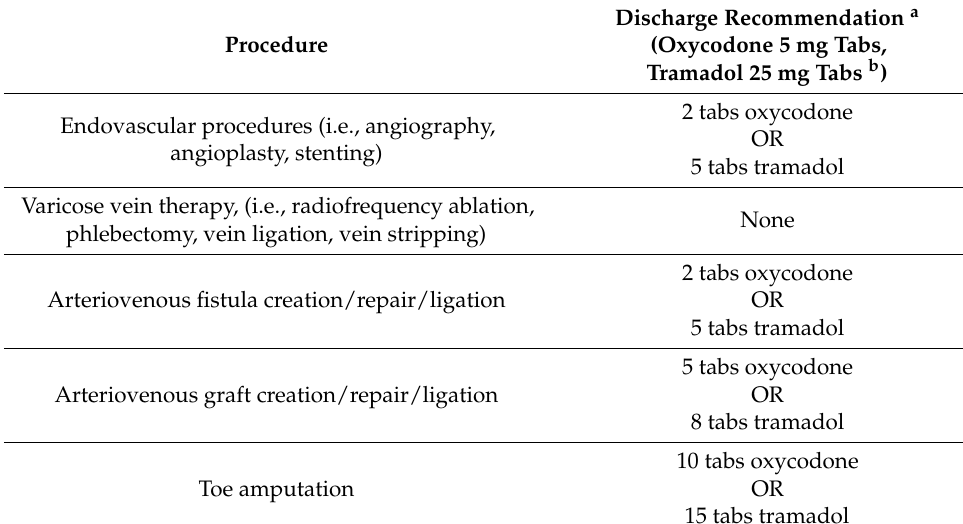
Table A4. VAPHS Opioid Prescribing Outpatient/Observation Guidelines: Vascular Surgery.